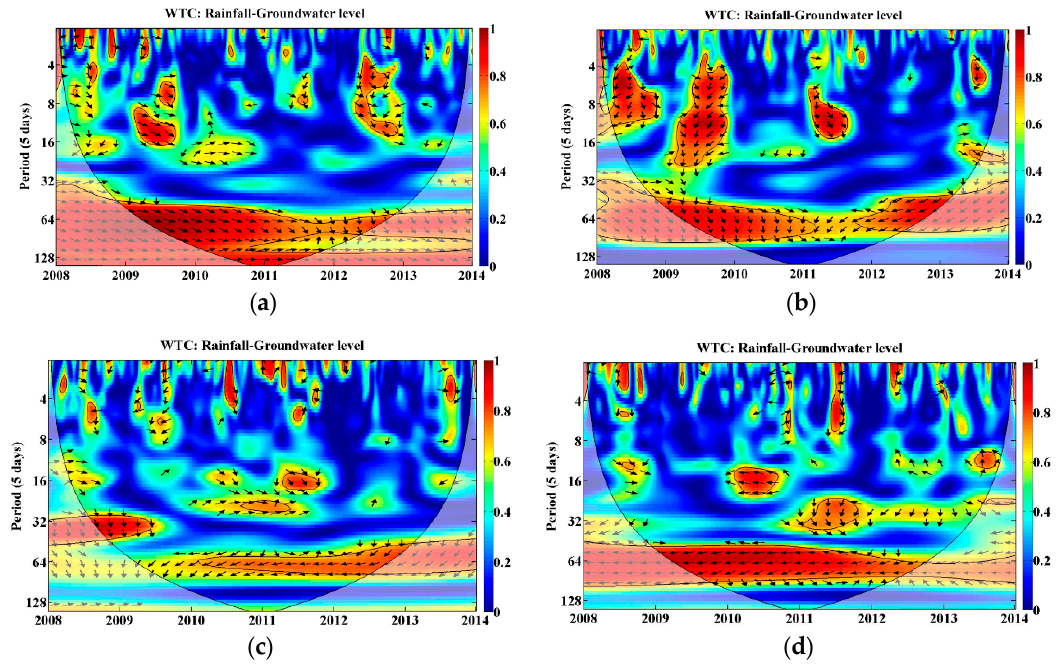
Figure 6. The wavelet coherence (WTC) between precipitation and groundwater in the Naoli River Basin, Northeast China, for pattern 1 ( a ); pattern 2 ( b ); pattern 3 ( c ); and pattern 4 ( d ), respectively. The significant level of 5% for red noise is displayed as a thick contour, and the relative relationship of phase is denoted as arrows (with anti-phase pointing left, in-phase pointing right).